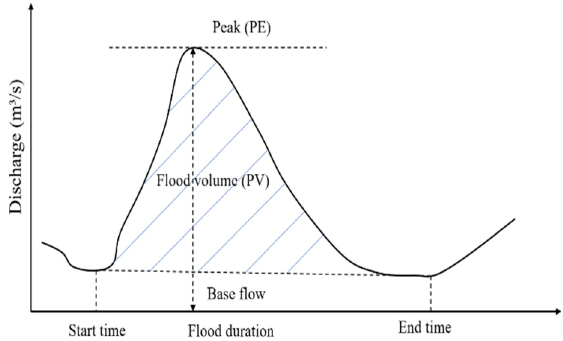
Figure A1. Typical flood hydrograph showing flood flow characteristics.